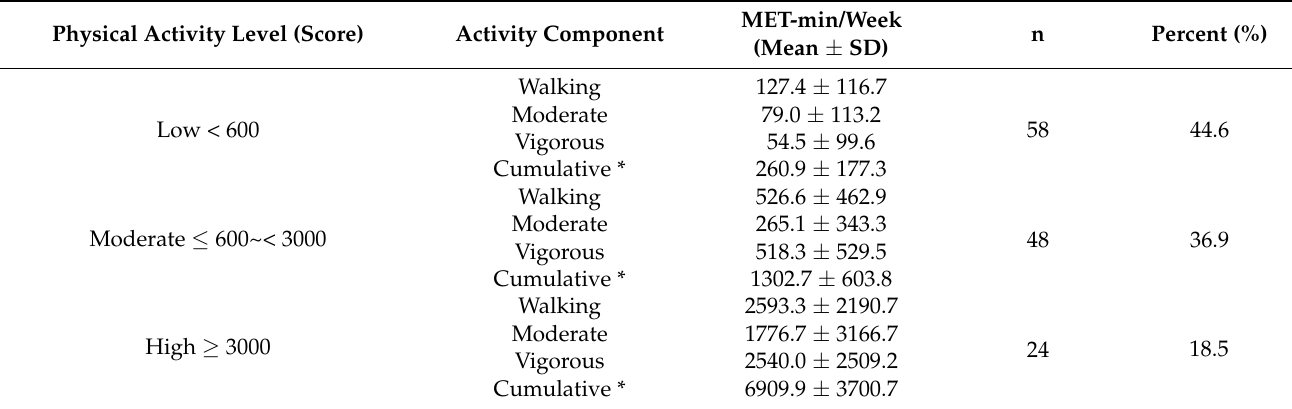
Table 3. Physical activity level of school